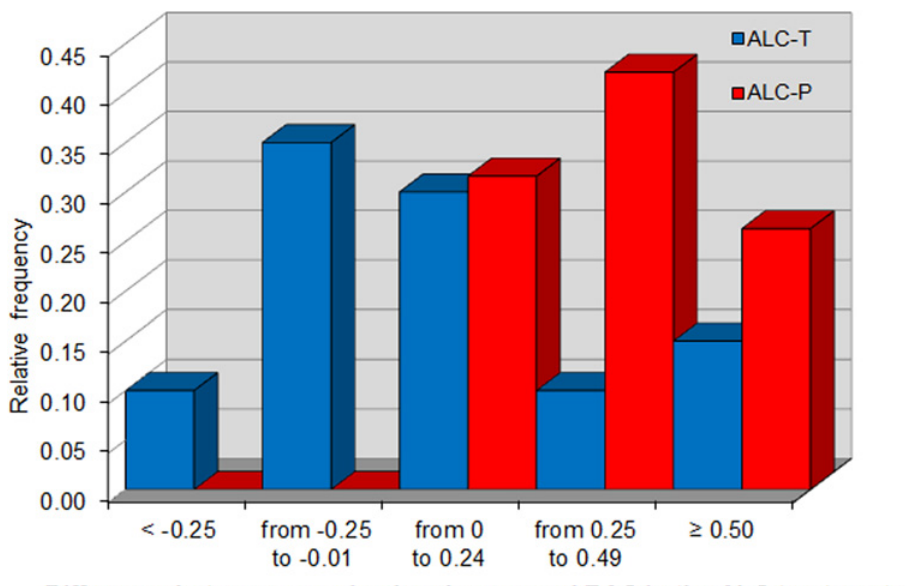
Fig 3. Misperception of Blood Alcohol Concentration